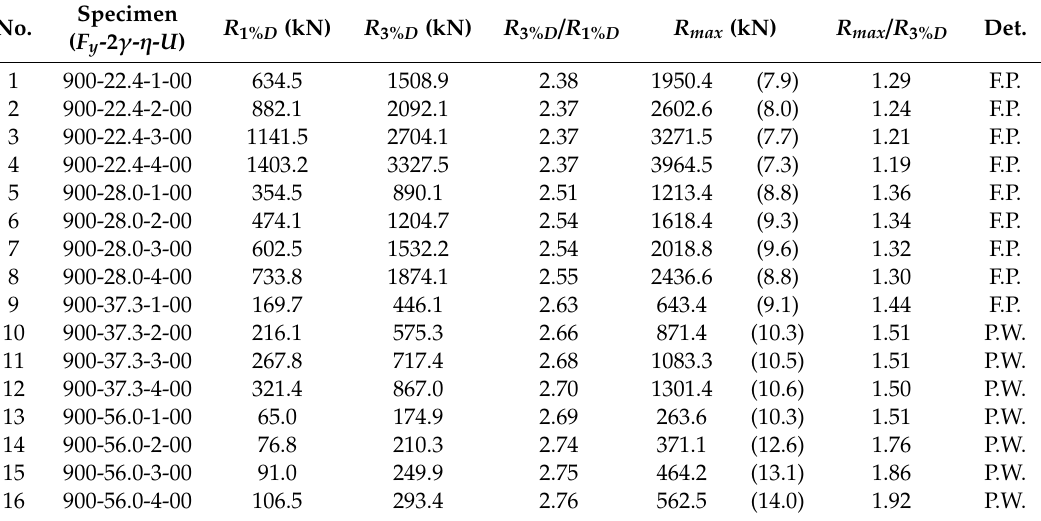
Table 10. Parametric analysis results of S900 ( F y = 900 MPa).